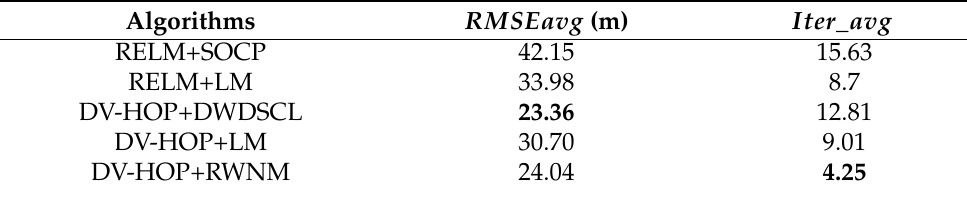
Figure 3. ( a ) RMSEavg and ( b ) Iter _ avg after running five iterative algorithms over 10 multi-hop isotropic networks with R = 35 m and nfe = 0.1. Outliers levels are increased by steps of 10% from 0% to 50%. Table 2. RMSEavg and Iter _ avg at different outliers values using R = 35 m and nfe = 0.1, the best performances in RMSE average and iteration average are denoted in bold